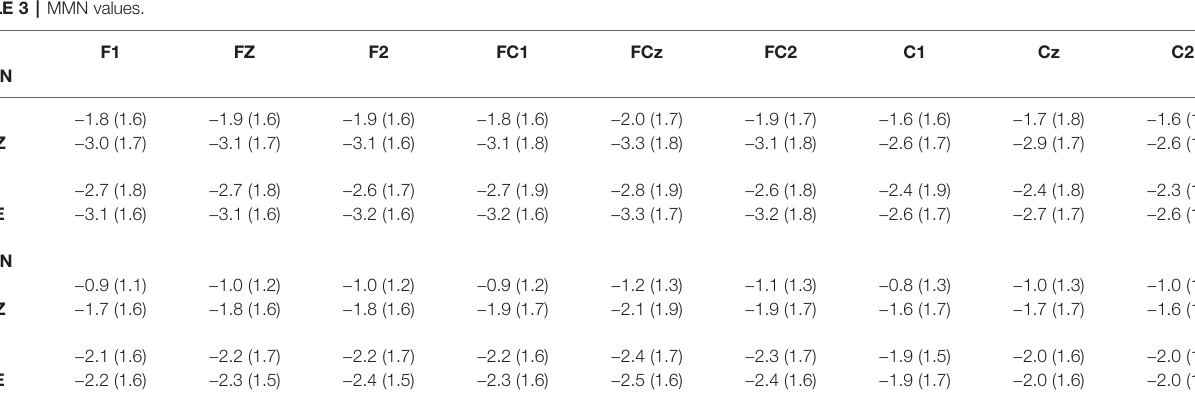
TABLE 3 | MMN values.